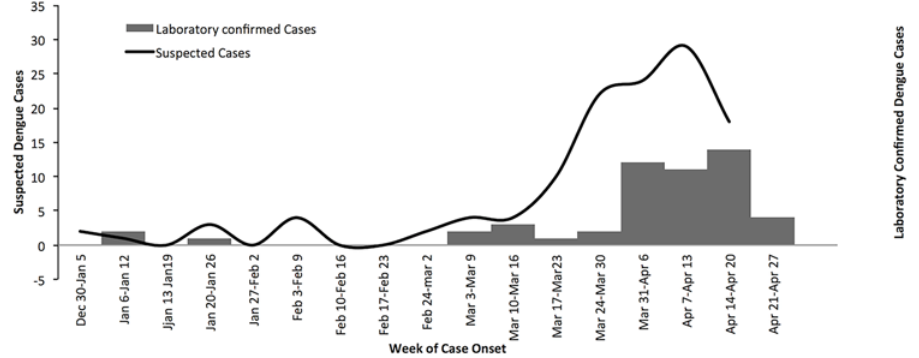
Fig 1. Epidemiological curve of 267 suspected dengue cases detected at hospitals from January – May, 2013, of which 155 (58%) were confirmed to have a current DENV infection and included a single fatal case.